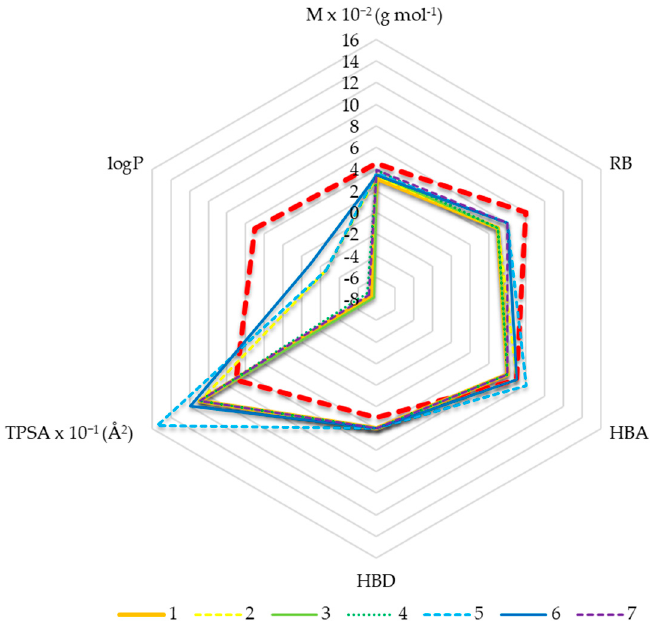
Figure 5. According to the results, dioximes possess characteristics such as the molecular weight (M), number of hydrogen bond acceptors (HBA), and number of rotating bonds (RB), which are within the recommended values for CNS active compounds [30]. Contrary, they exceed the limit of the number of hydrogen bond donors (HBD) and the topological polar surface area (TPSA). In addition, all compounds have a negative log P value, indicating low lipophilicity and therefore a low potential to be passively transported across BBB.